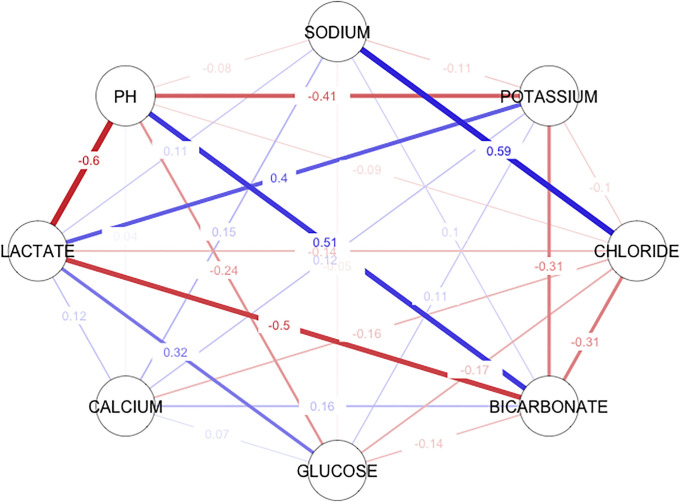
Correlation network of the bivariate (Pearson’s) correlation of the electrolyte, metabolite, and acid-base parameters between ICU patients who remained stable and those who physiologically deteriorated and died in 0–8 hours.Blue lines represent positive correlations, while red lines represent negative correlations. The thicker and darker a line is, the stronger the correlation.